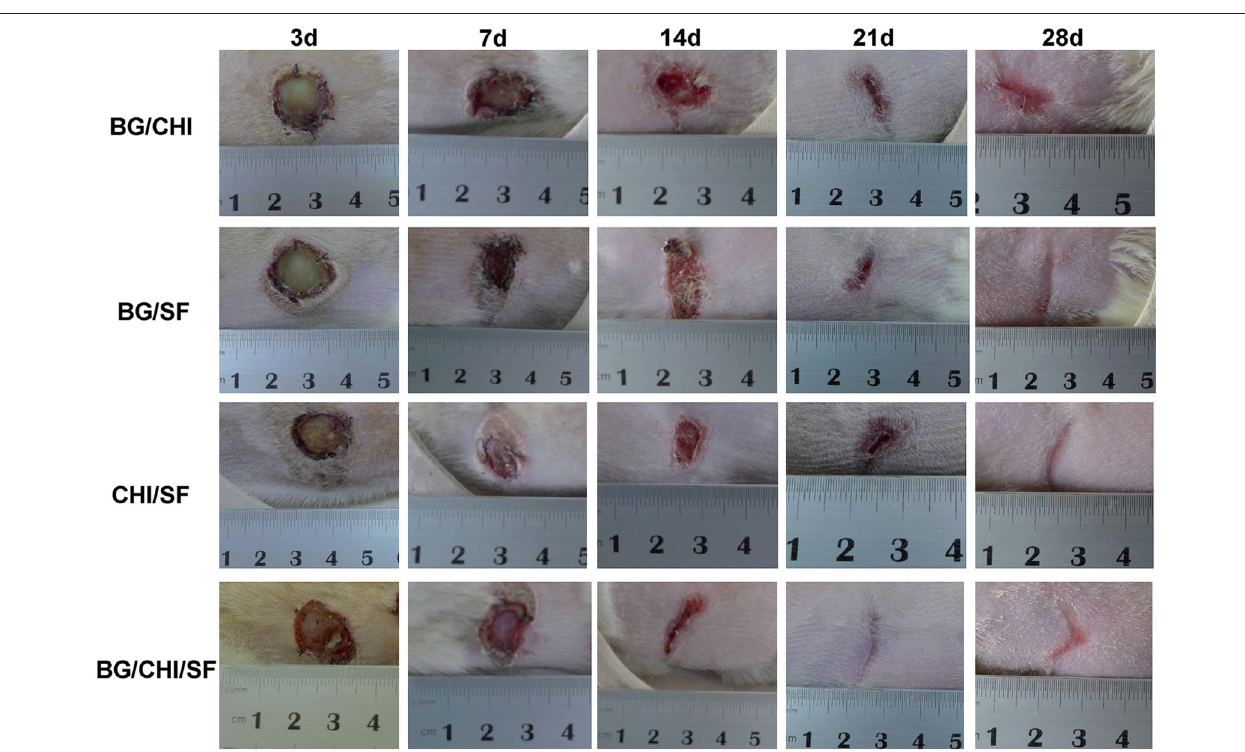
FIGURE 3 | Direct observation of the burn wounds created in rats and treated with silk fibroin (SF)/chitosan (CHI), BG/SF, BG/CHI and BG/CHI/SF scaffolds after 3, 7, 14, 21, and 28 days. Reproduced with permission from Li et al. (2016a). strains ( K. pneumonia , S. aureus , E. coli , and P. aeruginosa ) isolated from patients with burns (Gholipourmalekabadi et